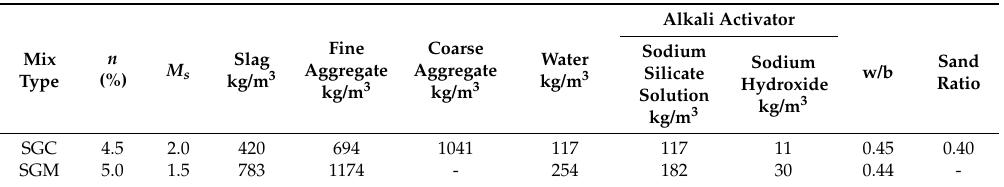
Table 3. Mix proportions of SGM and